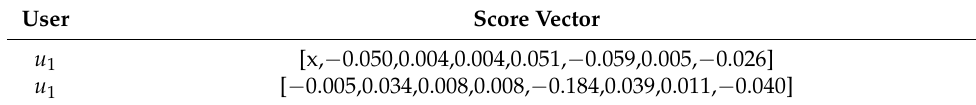
Table A3. Score in